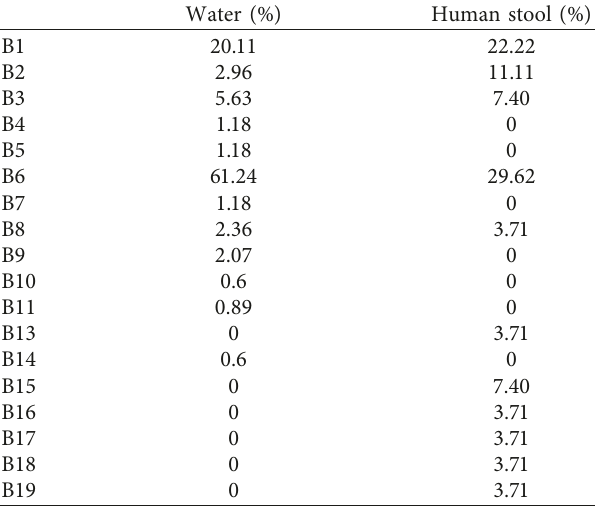
Table 2: Repartition of biotypes in water and human